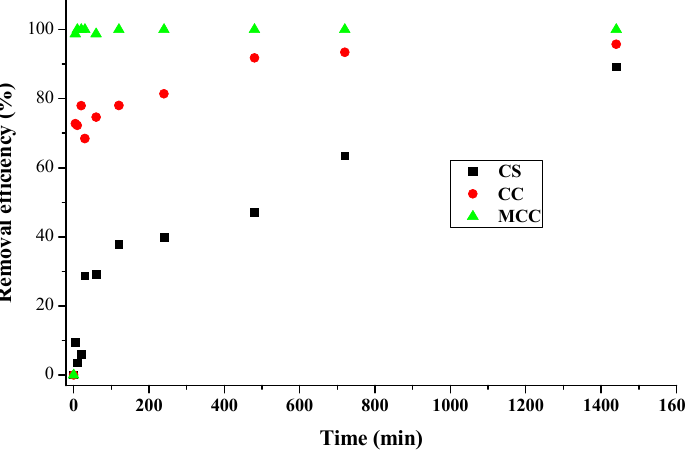
Figure 5. Effect of time on adsorption efficiency of CR.